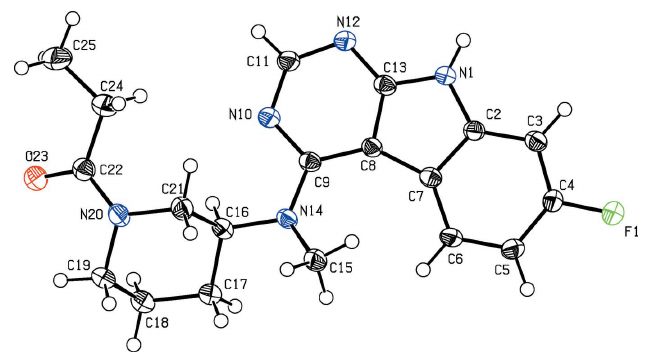
Figure 1 Perspective view of the title compound. Displacement ellipsoids are drawn at the 50% probability level.